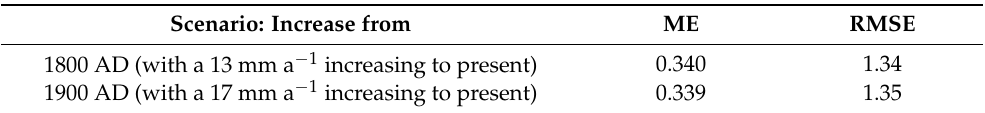
Table 2. Model efficiency for the best performing scenario of sedimentation increase based on radiocarbon ages of the Dembelle floodplain.